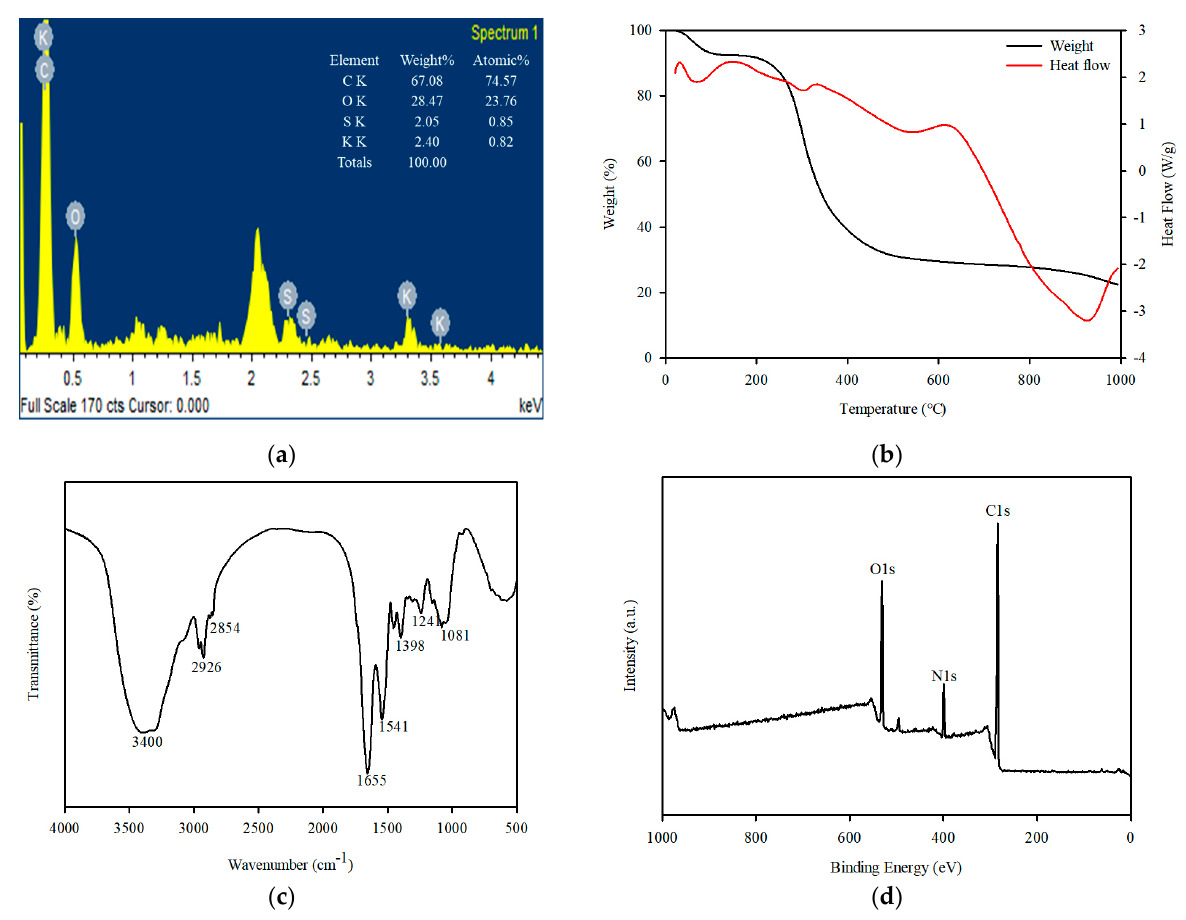
Figure 1. Characteristics of Spirulina platensis : ( a ) EDS pattern (inset = chemical composition), ( b ) TGA, ( c ) FTIR spectrum, and ( d ) XPS survey spectra.